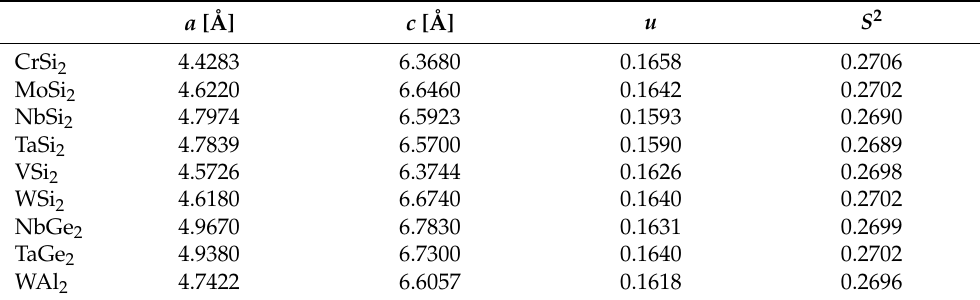
Table 8. Chirality of compounds with C 40 structure. Given are the lattice ( a , c ) and position ( u ) parameters, as well as the continuous chirality measures ( S 2 ). Lattice parameters are from the Pearson database